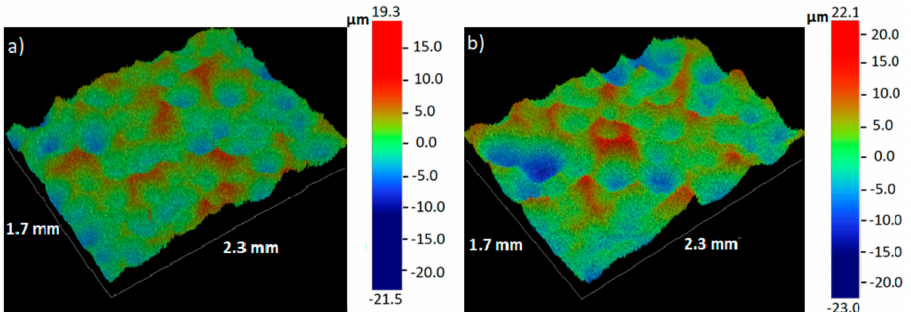
Figure 1. Optical profiler images for magnesium samples surface mechanical attrition treatment (SMAT)ed for 60 s ( a ) and 120 s ( b ).